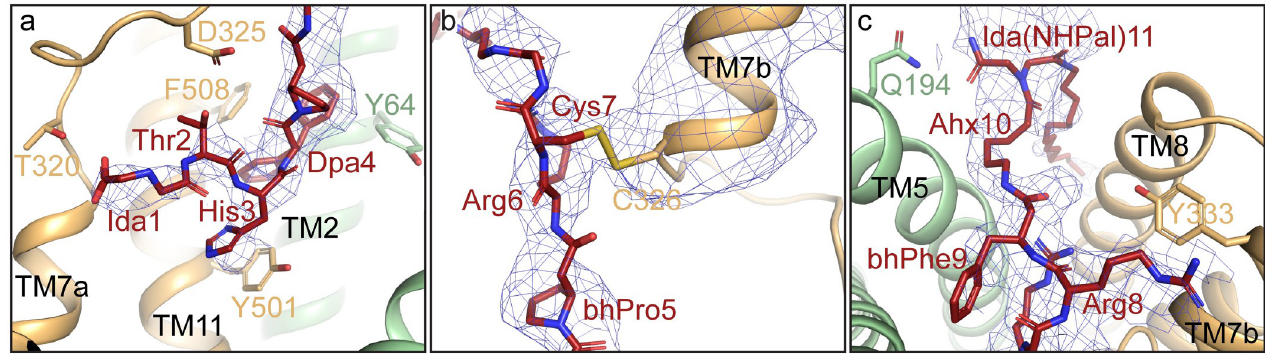
Fig 5. Interactions between PR73 and HsFpn. ( a ) Zoomed-in view of the first 4 residues of PR73 peptide. The density of PR73 is contoured at 4.5 σ as blue mesh. Residues of HsFpn forming interactions with PR73 are shown as side-chain sticks. ( b ) Zoomed-in view of residues 5–7 of PR73 displayed in the same representation as in ( a ). The density of TM7b is contoured at 4.5 σ as blue mesh. ( c ) Zoomed-in view of the last 4 residues of PR73 shown in the same representation as in ( a